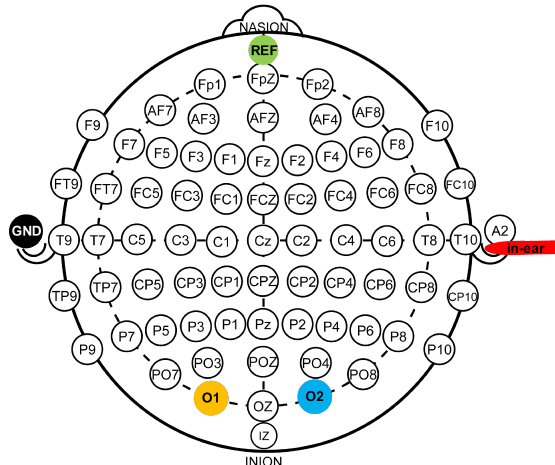
Figure 5. Electrode layout for EEG data